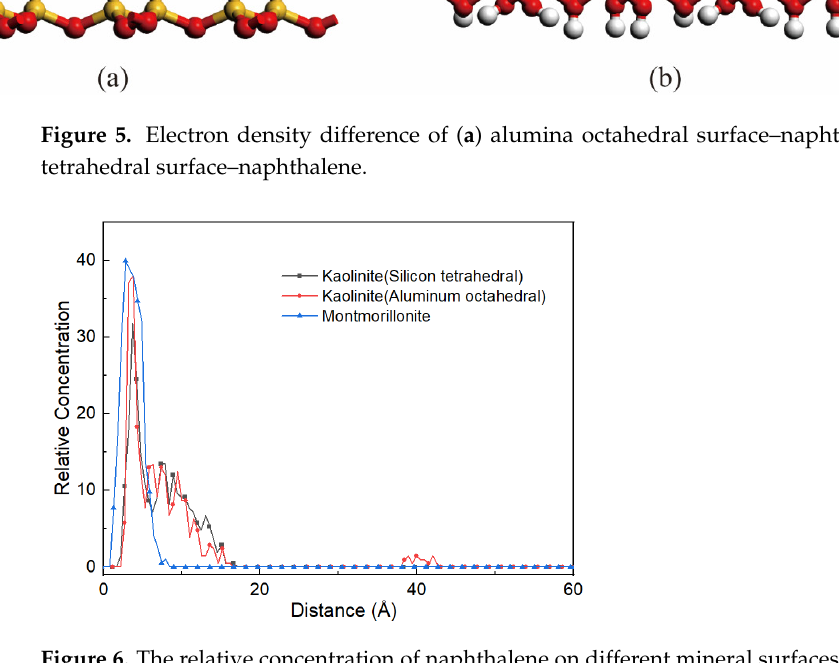
Figure 6. The relative concentration of naphthalene on different mineral surfaces.